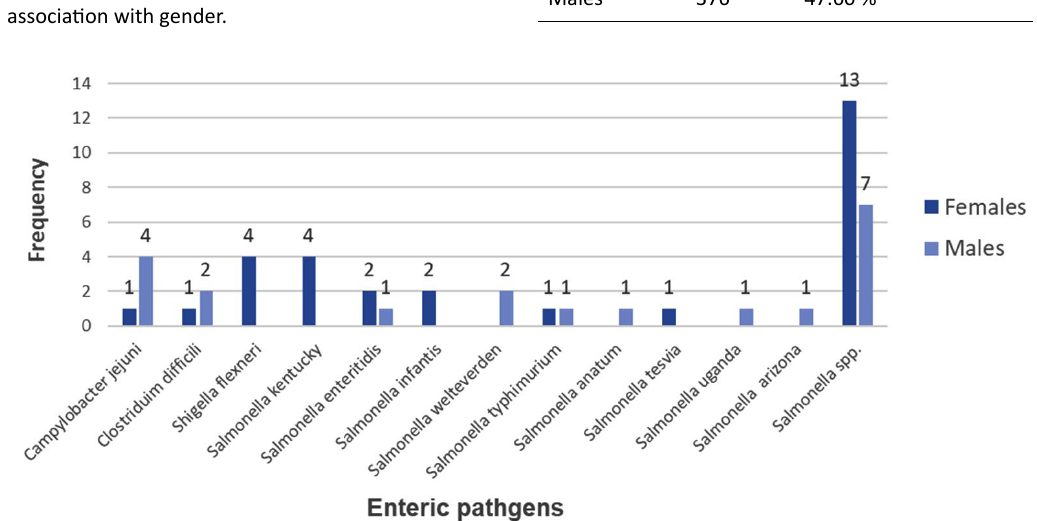
association with gender.